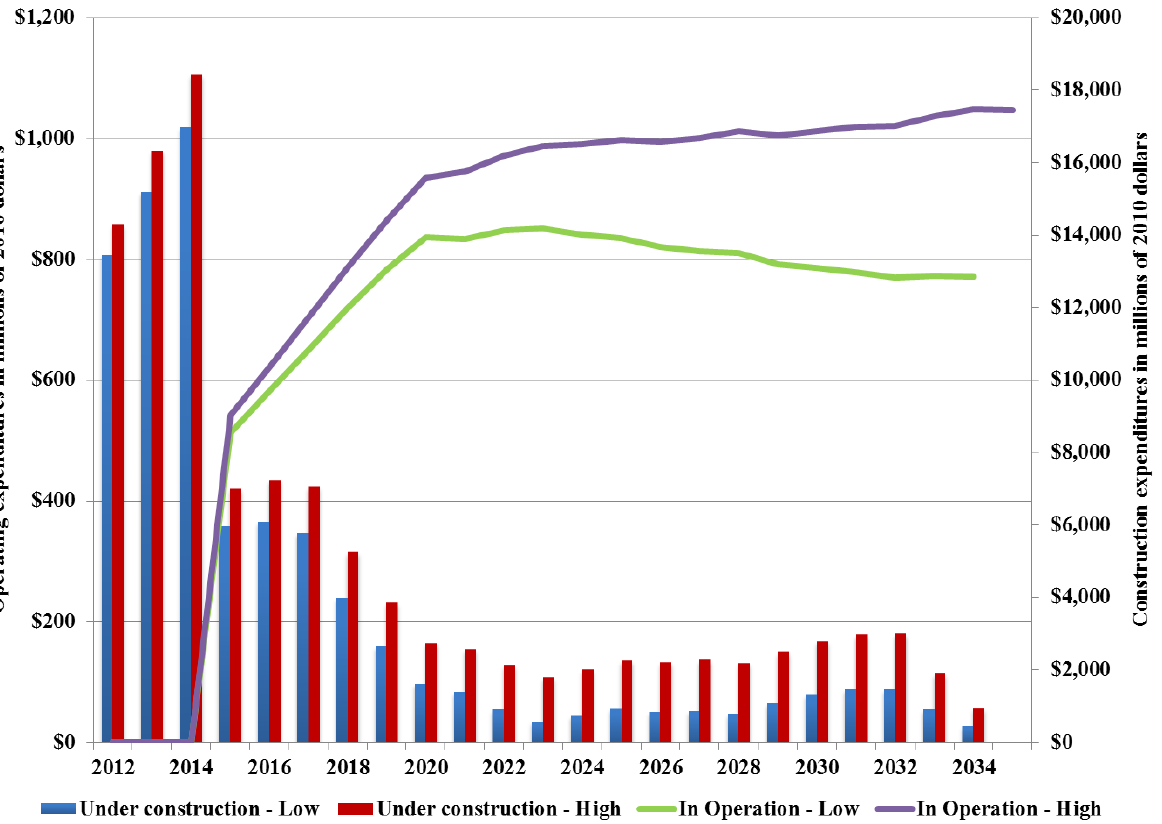
Figure 12. Capital and operating expenditures for renewable energy under